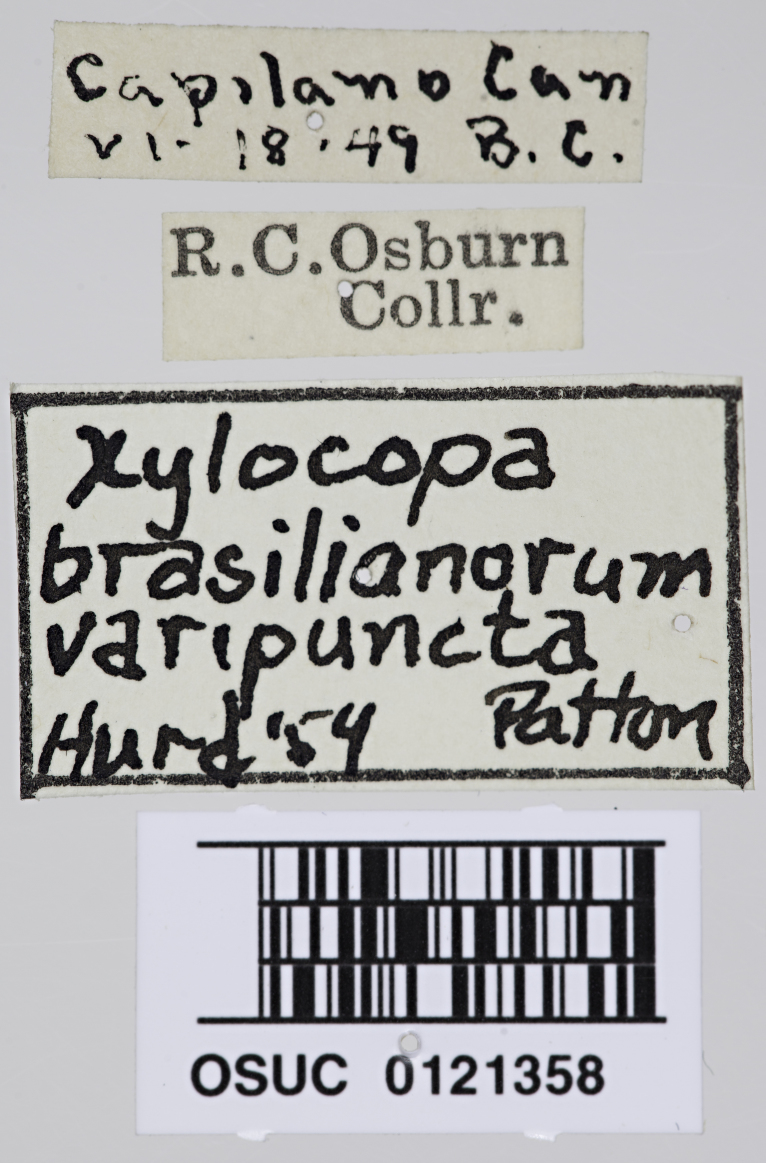
Specimen labels